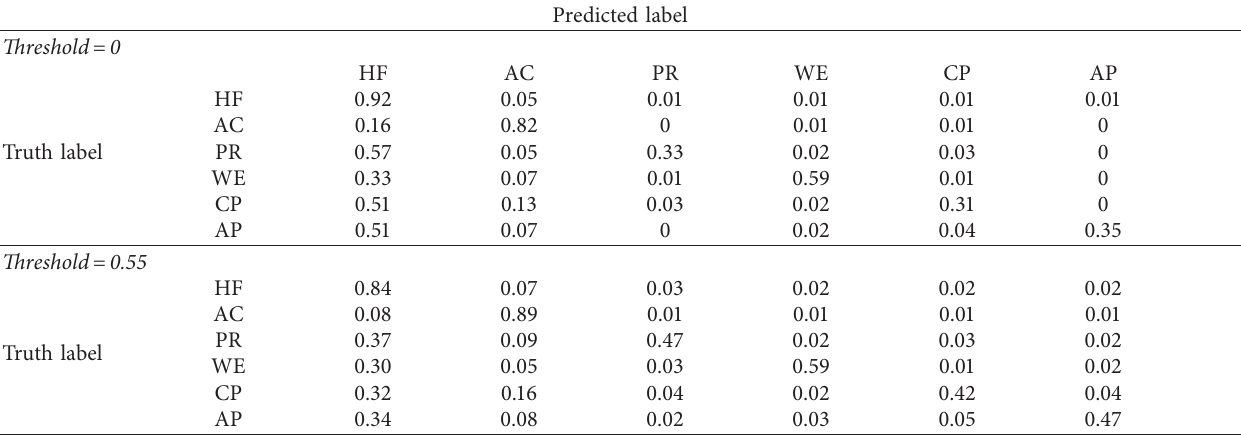
Table 8: Comparison of the confusion matrix of the single label with and without the threshold (orthogonal values highlighted). Predicted label